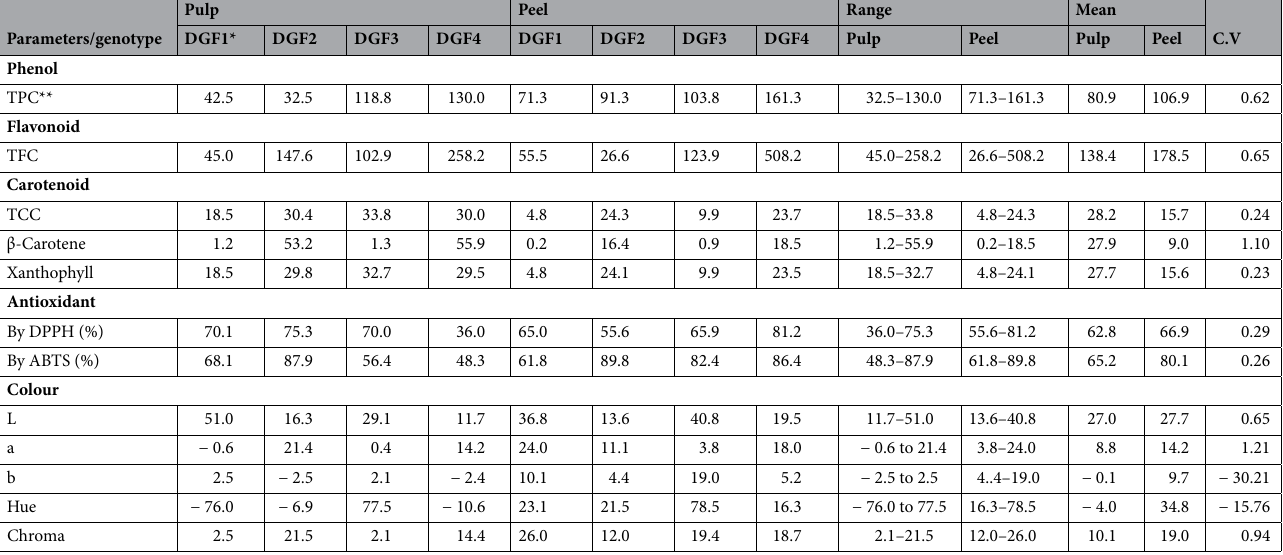
Table 4. Biochemical parameters including colour values of three dragon fruit ( Hylocereus ) species under Andaman and Nicobar Island conditions of India. *DGF1 = Hylocereus undatus ; DGF2 and DGF4 = Hylocereus costariscensis ; DGF3 = Hylocereus megalanthus . **TPC = Total phenol content (mgGAE 100 g −1 ); TFC = Total flavonoid content (mgRE 100 g −1 ); TCC = Total carotenoid content (µg g −1 ); β-Carotene (µg 100 g −1 ); Xanthophyll (µg g −1 ).